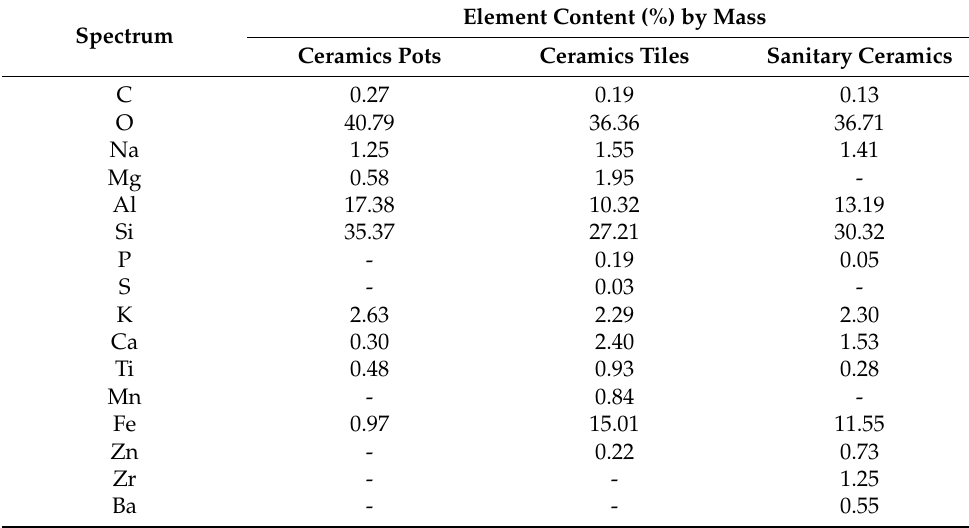
Figure 4. SEM images of the used ceramic fine fillers obtained from ceramic pots, ceramic tiles and sanitary ceramic. Table 5. Elemental composition of ceramics obtained by the means of SEM/EDX method.